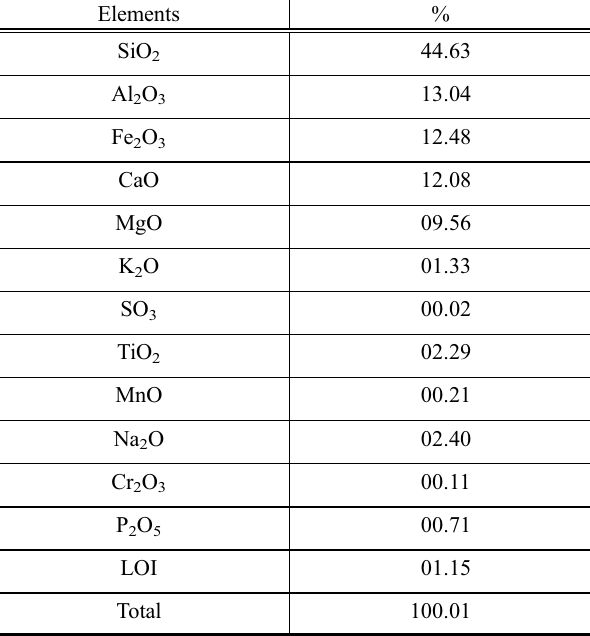
Table 3 Chemical composition of